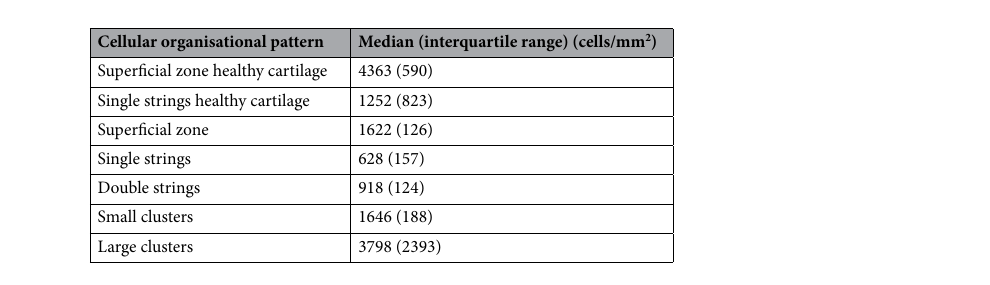
Table 1. Cellular density as a function of cellular